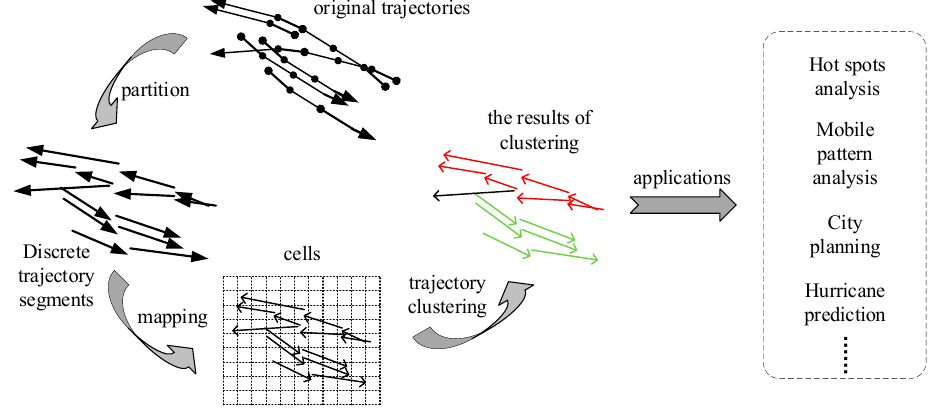
Figure 1. The illustration of the proposed ATCGD approach.